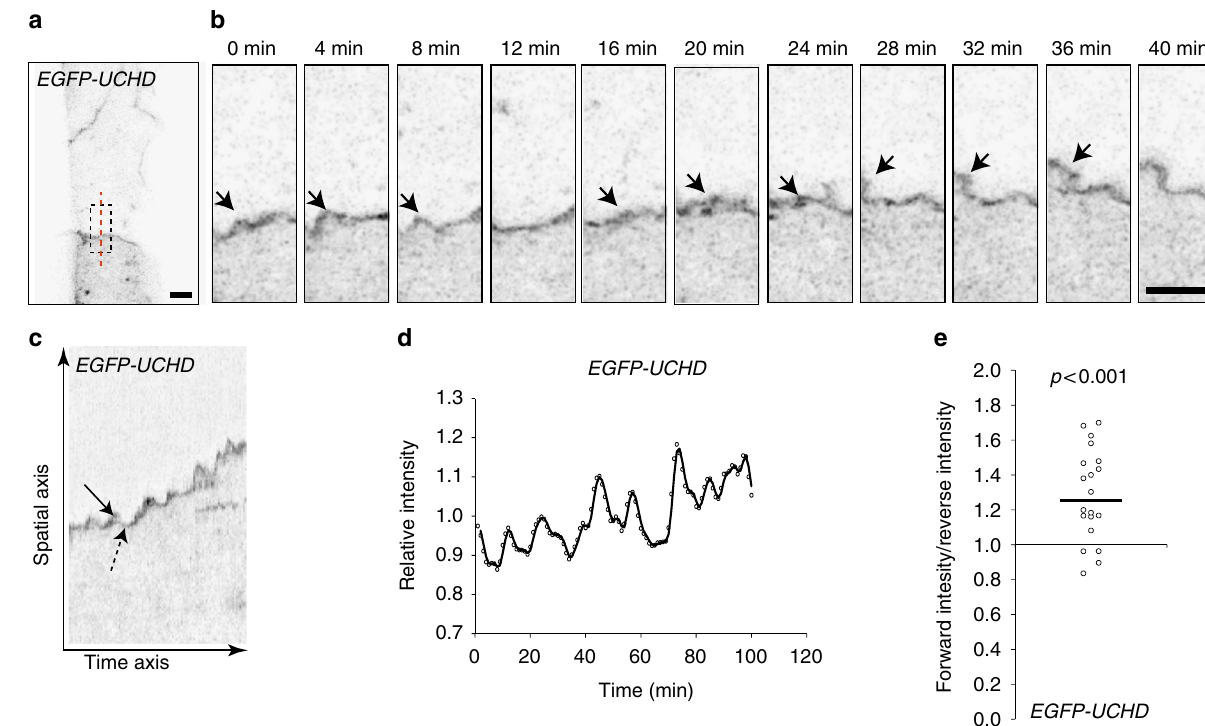
Fig. 3 Oscillatory F-actin dynamics during remodeling of cell – cell junctions. a , b Still images from a movie (Supplementary Movie 4) showing JBL formation in the dorsal aorta of an EGFP-UCHD expressing 2dpf embryo ( Tg( fl i:Gal4ff ubs3 ; UAS:EGFP-UCHD ubs18 )), shown in inversed contrast. b A magni fi cation of the inset in a and the red dashed line indicates the site for kymograph in c . Arrows point to a JBL, seen as a local thickening of the junction. c Kymograph across the junction. Solid arrow denotes forward movement and dashed arrow backward movement of the junction. d Intensity plotting of a EGFP-UCHD JBL kymograph. e Scatter plot of the relative EGFP-UCHD intensity during forward and backward movements ( n = 20 events, 4 movies). EGFP-UCHD intensity value in a forward movement was divided with intensity value during subsequent reverse movement. Non-parametric one sample Wilcoxon signed rank test was used as statistical test. Scale bars 5 µ (Fig. 4b), allowing the analysis of differentially labeled F-actin